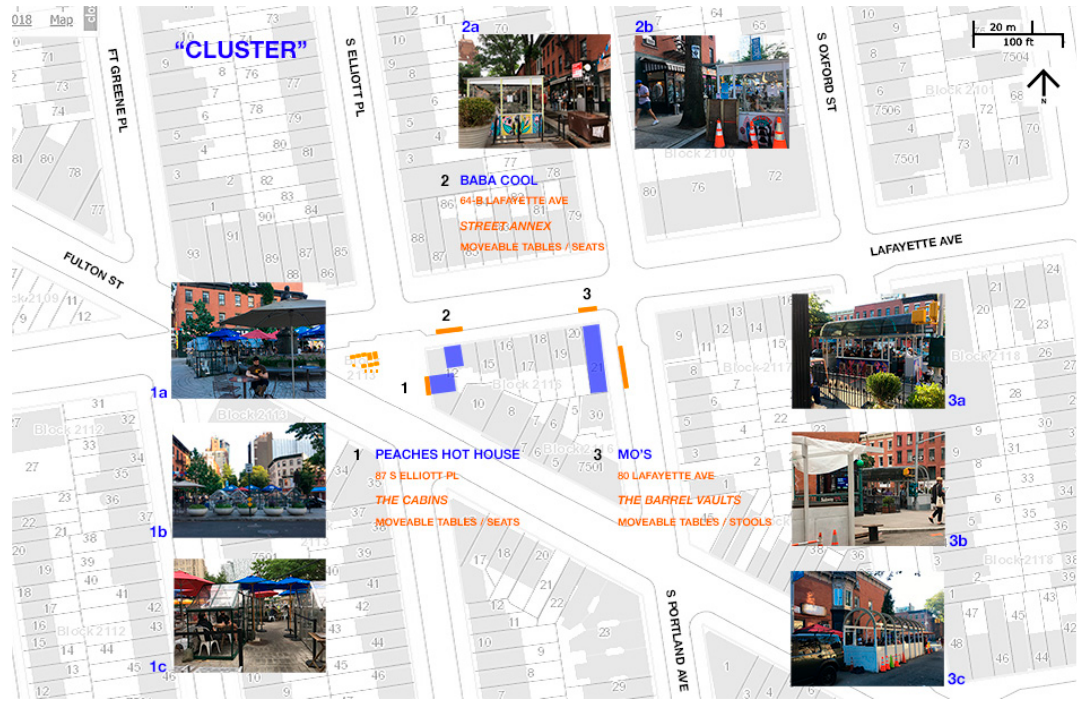
Figure 5. The Cluster: Peaches, Baba Cool and Mo’s invite a range of community expressions: orange denotes street constructions, blue denotes indoor parcel (Source: author) Dynamic remakings of street space in New York